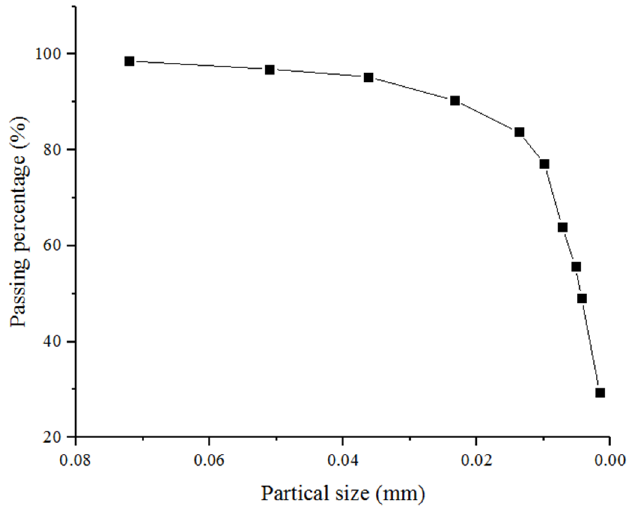
Figure 4. Grain size distribution of the sampled slurry. Table 3. Index properties of the sampled